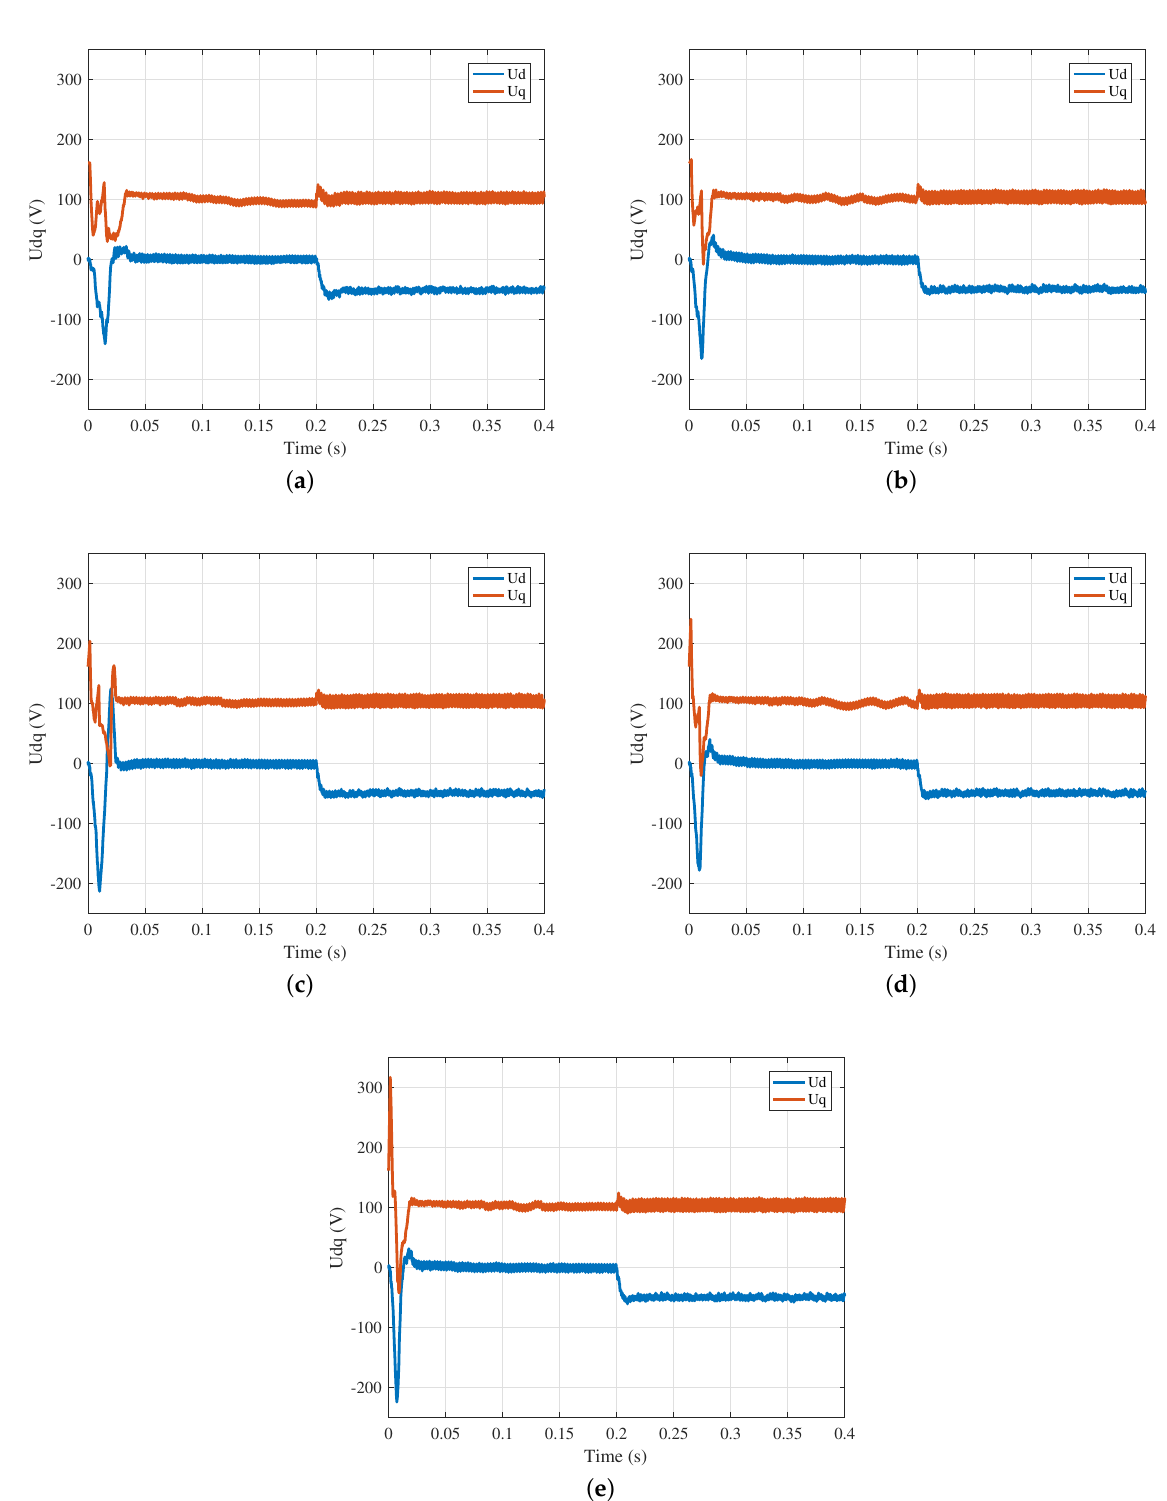
Figure 16. Voltage responses of u d and u q . ( a ) PI; ( b ) FDPI; ( c ) FDPI-HT; ( d ) FDPI-T1FDHT; ( e )